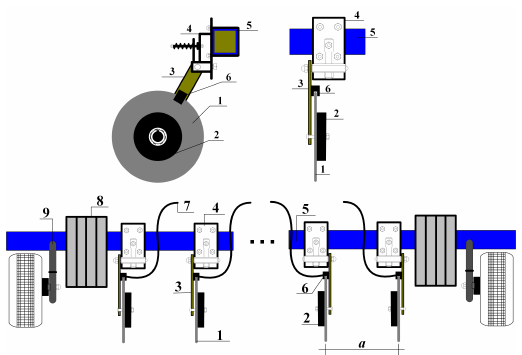
Figure 9. Partial view of